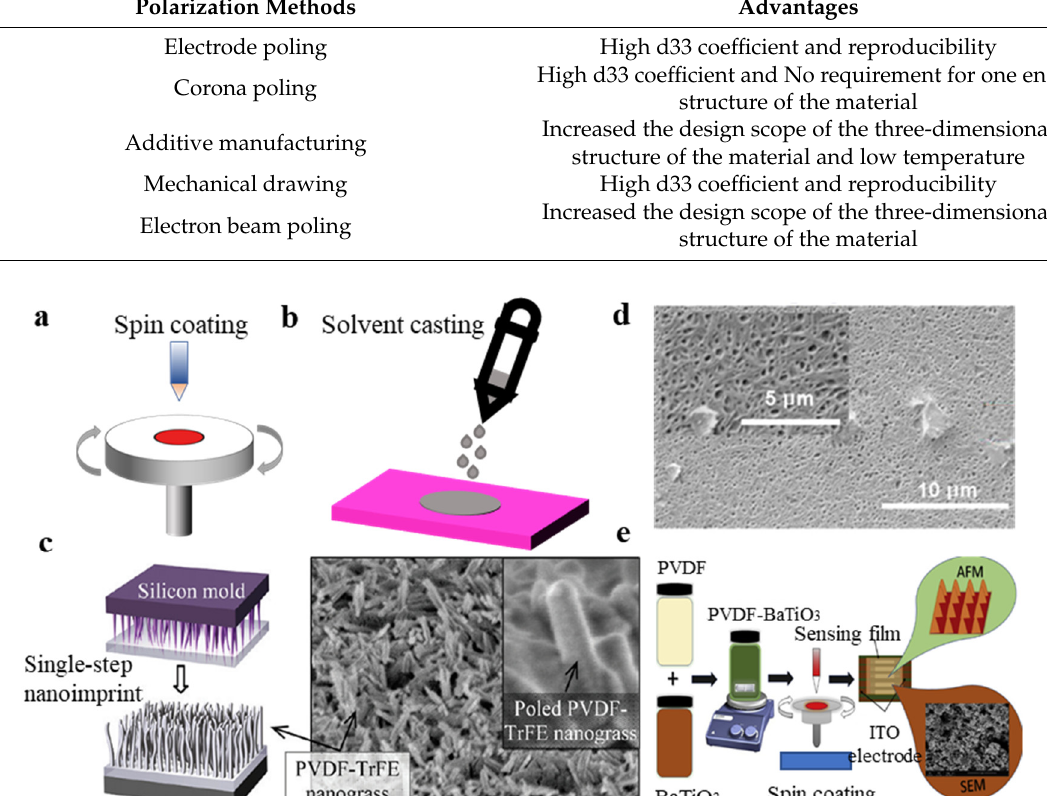
Figure 7. ( a ) Schematic diagram of the spin coating; ( b ) schematic diagram of the solvent casting; ( c ) spin-coated PVDF-TrFE was dissolved in MEK and the silicon mold was hot pressed on the film [120]; ( d ) SEM of PVDF–TrFE copolymer thin films fabricated by spin coating [121]; and ( e ) preparing the